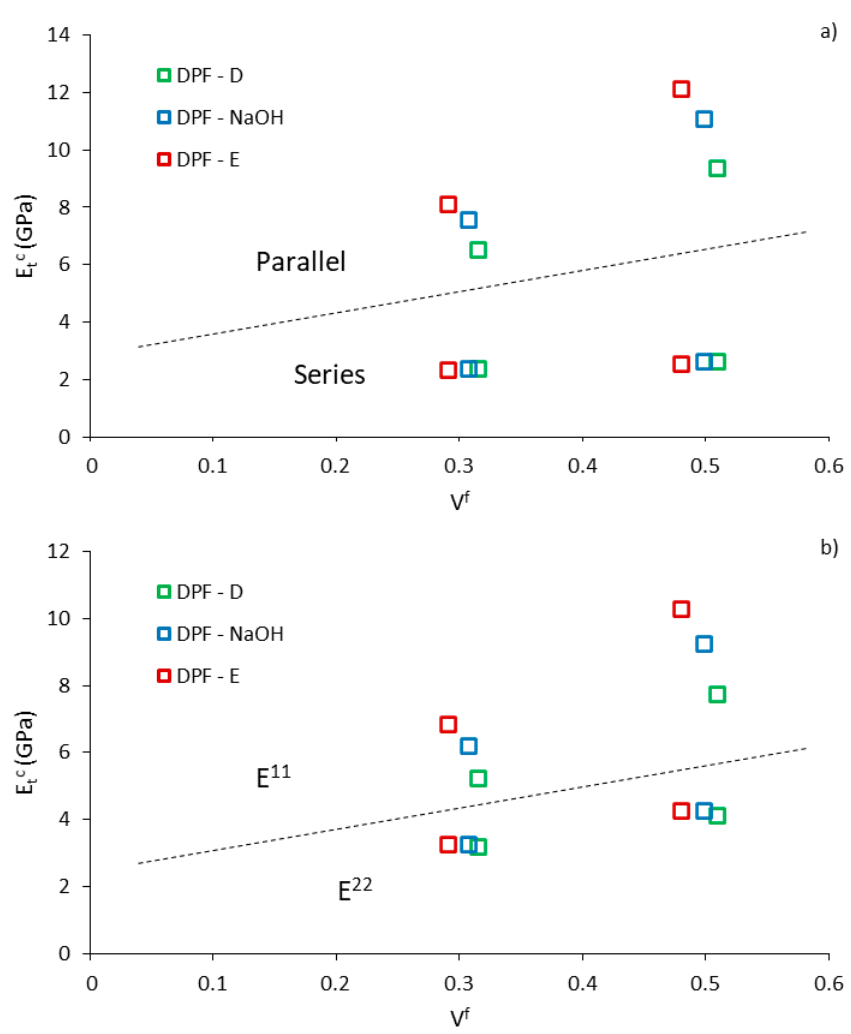
Figure 10. Evolution of the longitudinal and transverse modulus of the composites. ( a ) Parallel and series (Hirsch), ( b ) E11 and E22 (TP/HT).